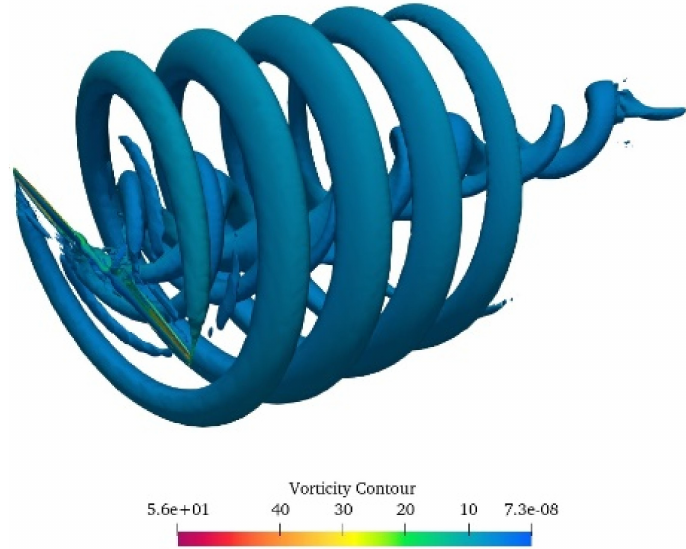
Figure 5. Vorticity contour of the simulation.